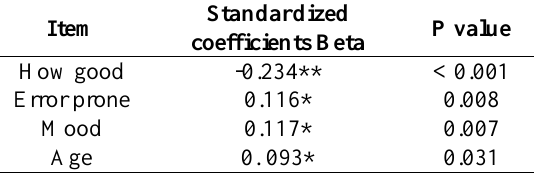
Table 8. Predictors of factor 3 (Lapse)